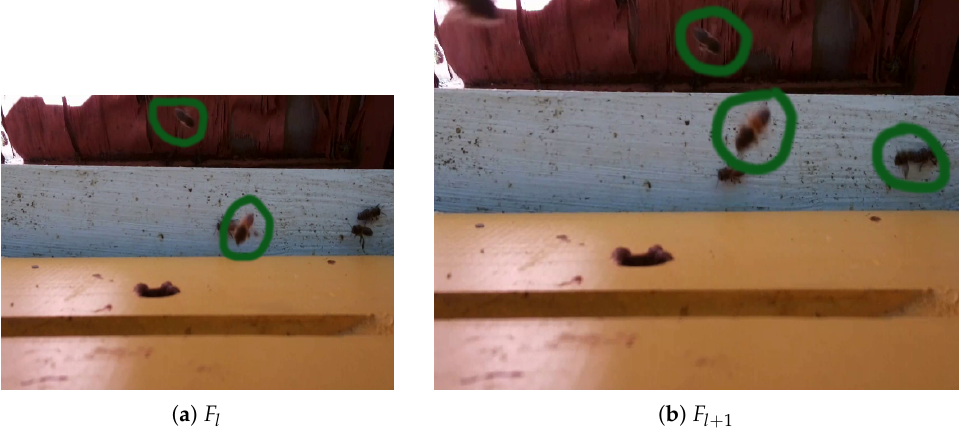
Figure 16. Two consecutive curated frames from a BeePi video; in both frames each full bee motion was marked by a human curator with a green